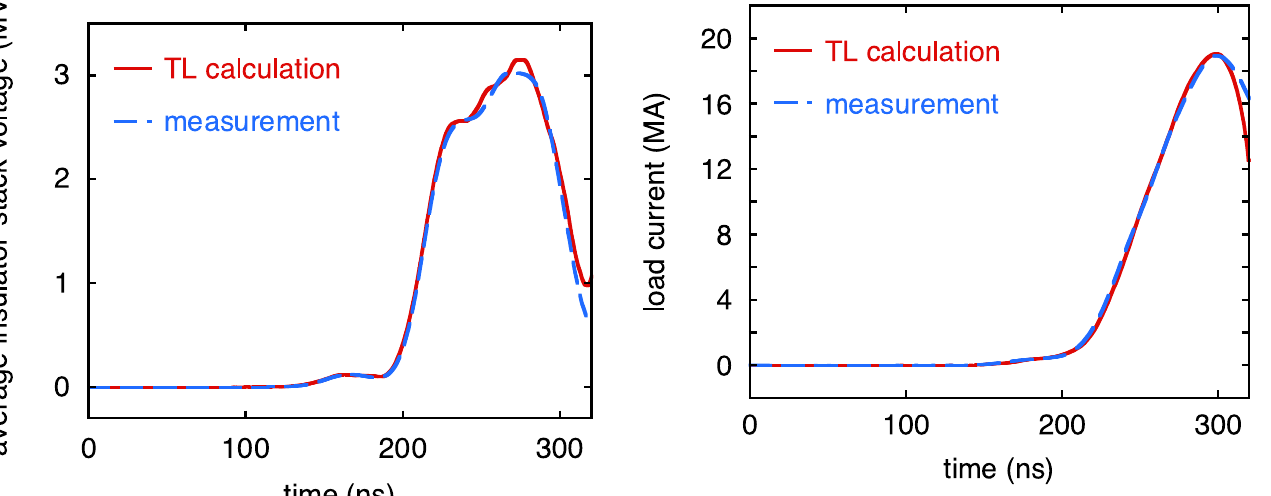
FIG. 10. (Color) Comparison of the TL -calculated z -pinch-load current, with the average measured load current, for the seven shots taken with Z ’s baseline load. (The average is taken over the shots. We assume that the measured load current is given by the inner-MITL current monitors, which were located 6 cm from the axis of the pinch.)